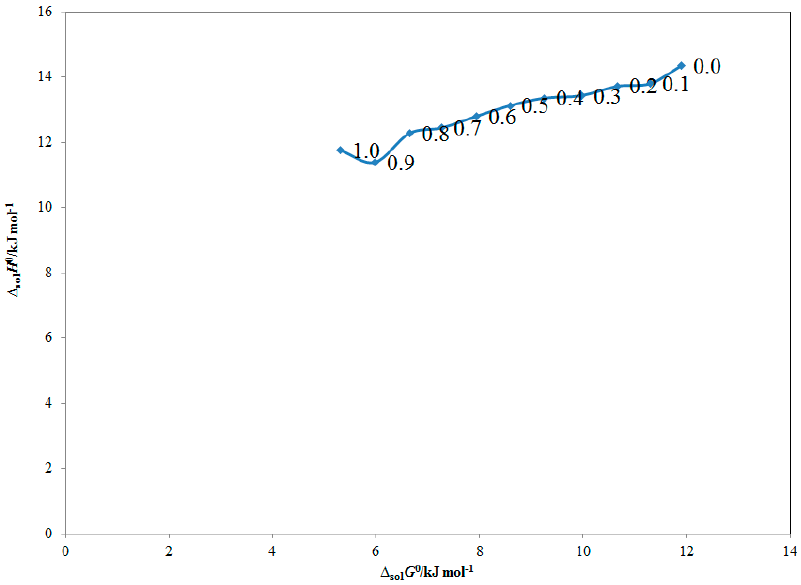
Figure 4. Apparent standard enthalpy ( ∆ sol H 0 ) vs. apparent standard Gibbs energy ( ∆ sol G 0 ) “enthalpy–entropy compensation” graph for ECT in different “PEG-400 + water” combinations at T hm value of 308 K.